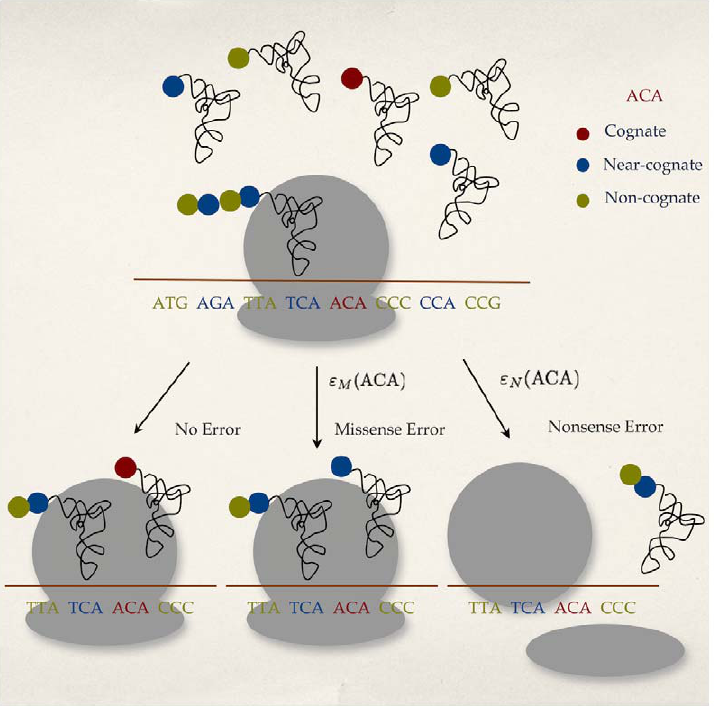
Figure 2. Model of translation errors. During translation, a ribosome pauses at a codon (ACA in this case) waiting for a cognate tRNA. During this pause, one of the three processes can take place: elongation by cognate tRNAs leading to no translation error, elongation by a near-cognate tRNA leading to a missense error with rate e M or premature termination of translation due to recognition by release factors, spontaneous ribosome drop- off or frameshifting leading to a nonsense error with a rate e N . Error rates vs. elongation rates Using E. coli strain K12/DH10B (K12) as an example, our estimates of codon-specific missense error rates e M ranged from 0 { 9 : 38 | 10 { 3 with a median of 2 : 50 | 10 { 3 . Six of the 61 sense codons have a predicted missense error rate of 0 as these codons have no near-cognate tRNA species (Table S2). These rates are higher than recent empirical estimates of missense error rates in E. coli , which vary from 2 : 0 | 10 { 4 { 3 : 6 | 10 { 3 with a median value of 3 : 4 | 10 { 4 [25]. This is likely due to the fact that the missense error estimates in [25] were for specific amino acid the rate of all possible missense errors at a given codon. Our predicted rates of codon-specific nonsense errors e N in E. coli